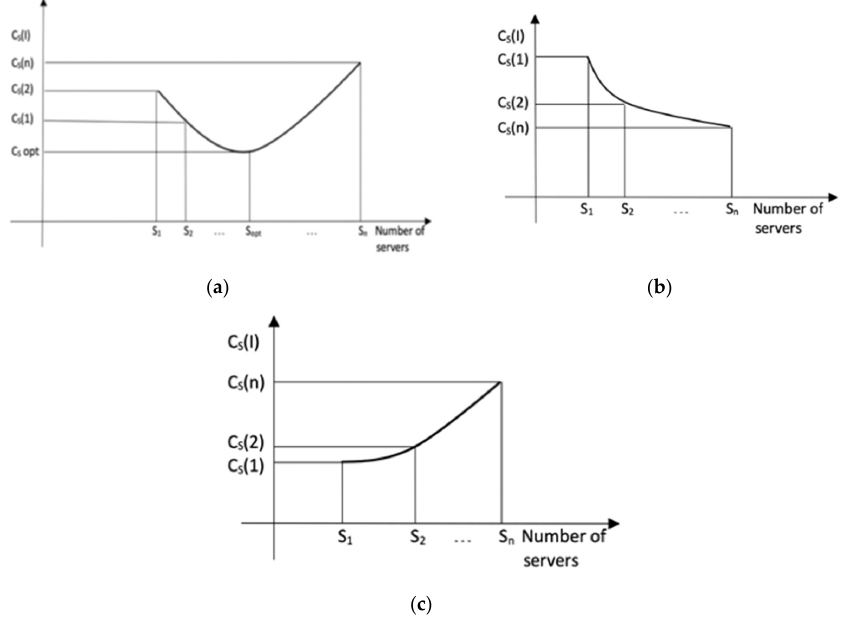
Figure 12. ( a ) The number of servers is large. ( b ) The number of servers is small. ( c ) The system has low load. ( a – c ) The values of costs C 1 and C 2 regarding the waiting of parts and machine tools in the reference time unit.